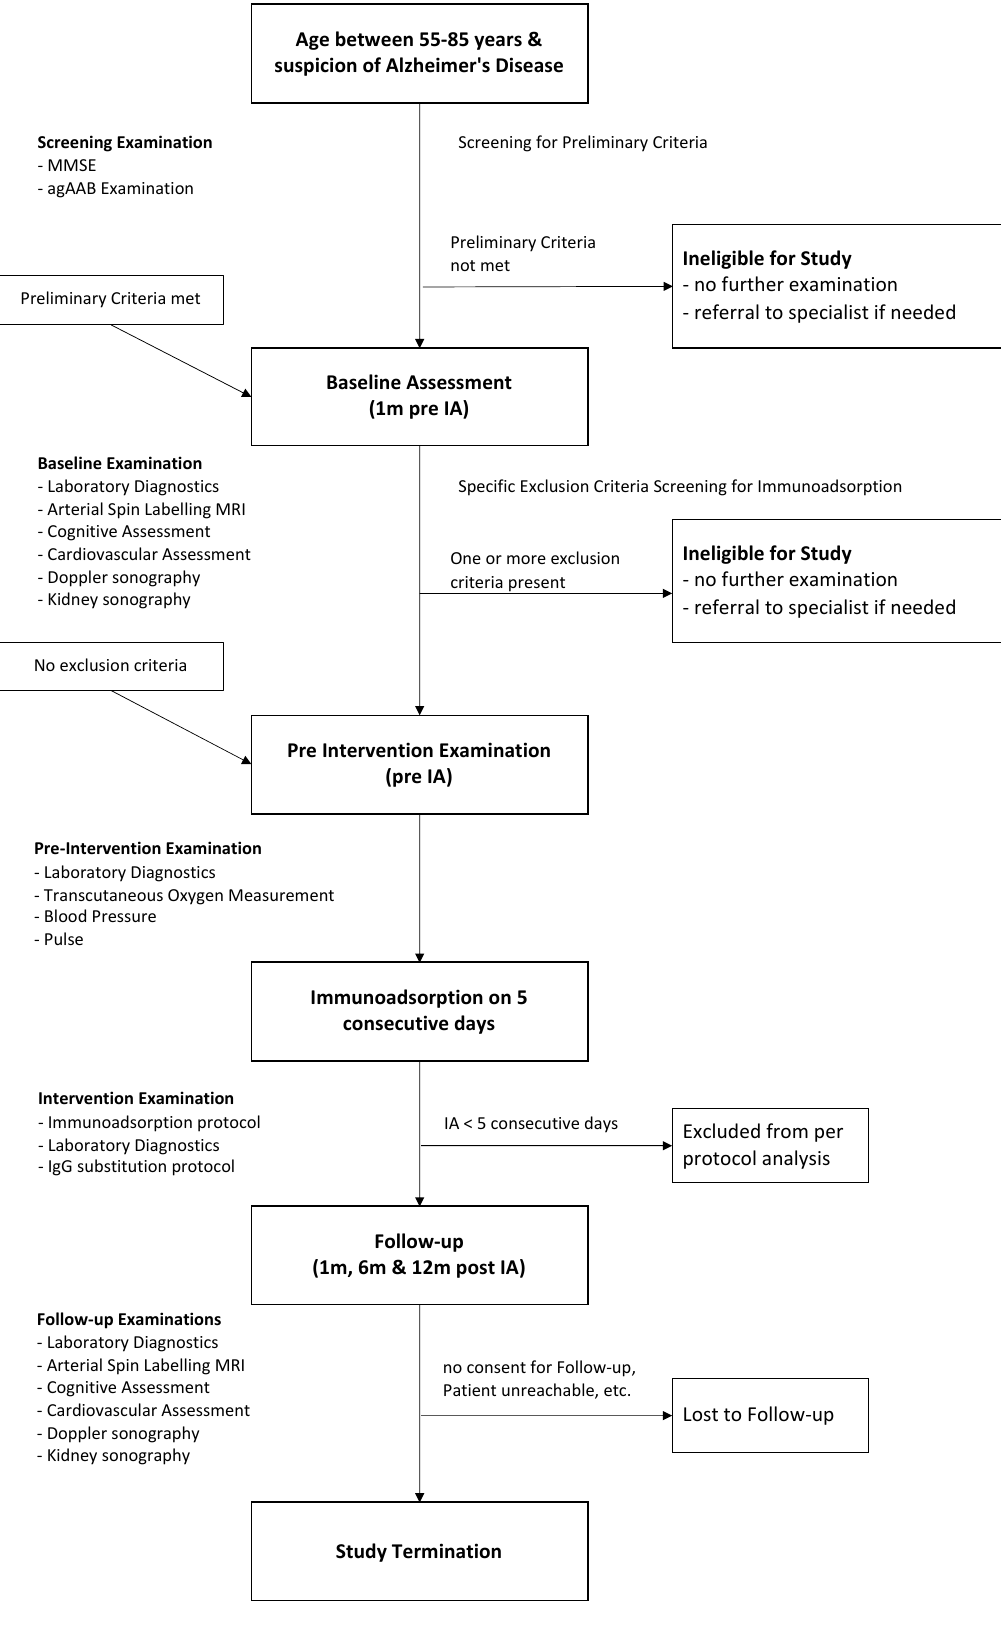
Figure 1. Study Figure 1. Study flow.